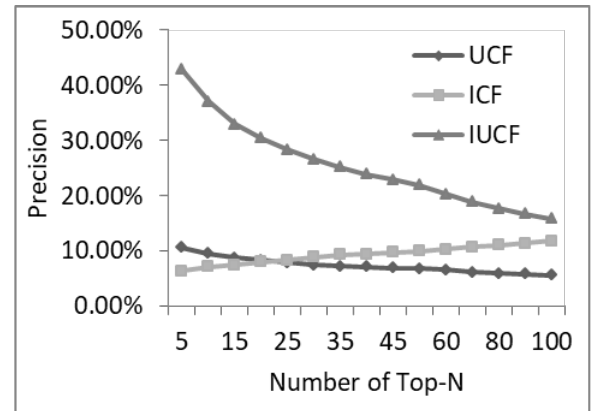
Figure 6. Comparison of precision with Top- N changes.